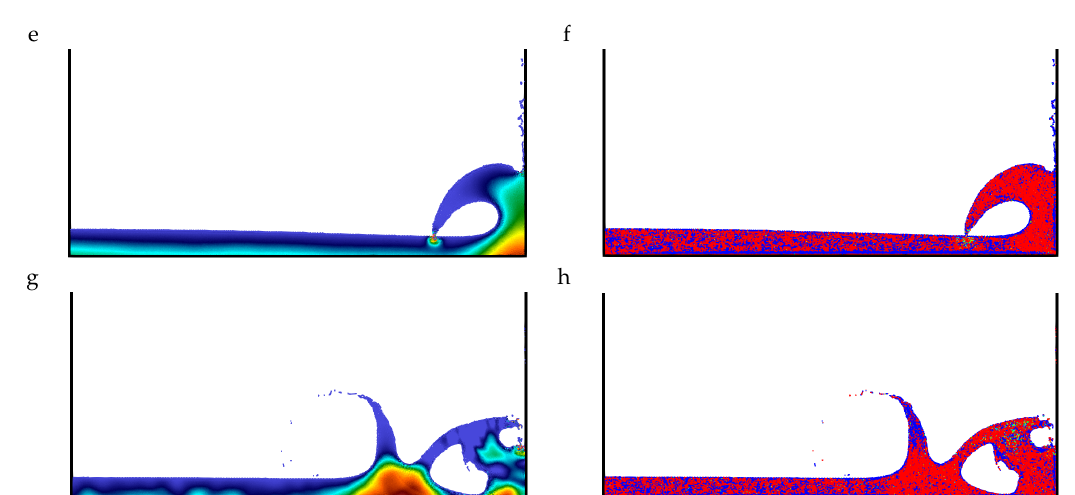
Figure 13. Two-dimensional dam-break flow: Snapshots of the computational results at different times (cid:112) t g / H for H / ∆ x 0 = 120. On the left column the pressure field is presented, (cid:101) field is placed on (cid:112) g / H = 2.35, ( c , d ) shows the results at t the right. Figures ( a , b ) shows the results for t (cid:112) g / H = 7.12. Figures ( g , h ) shows the results obtained at t whereas ( e , f ) plots the results for t